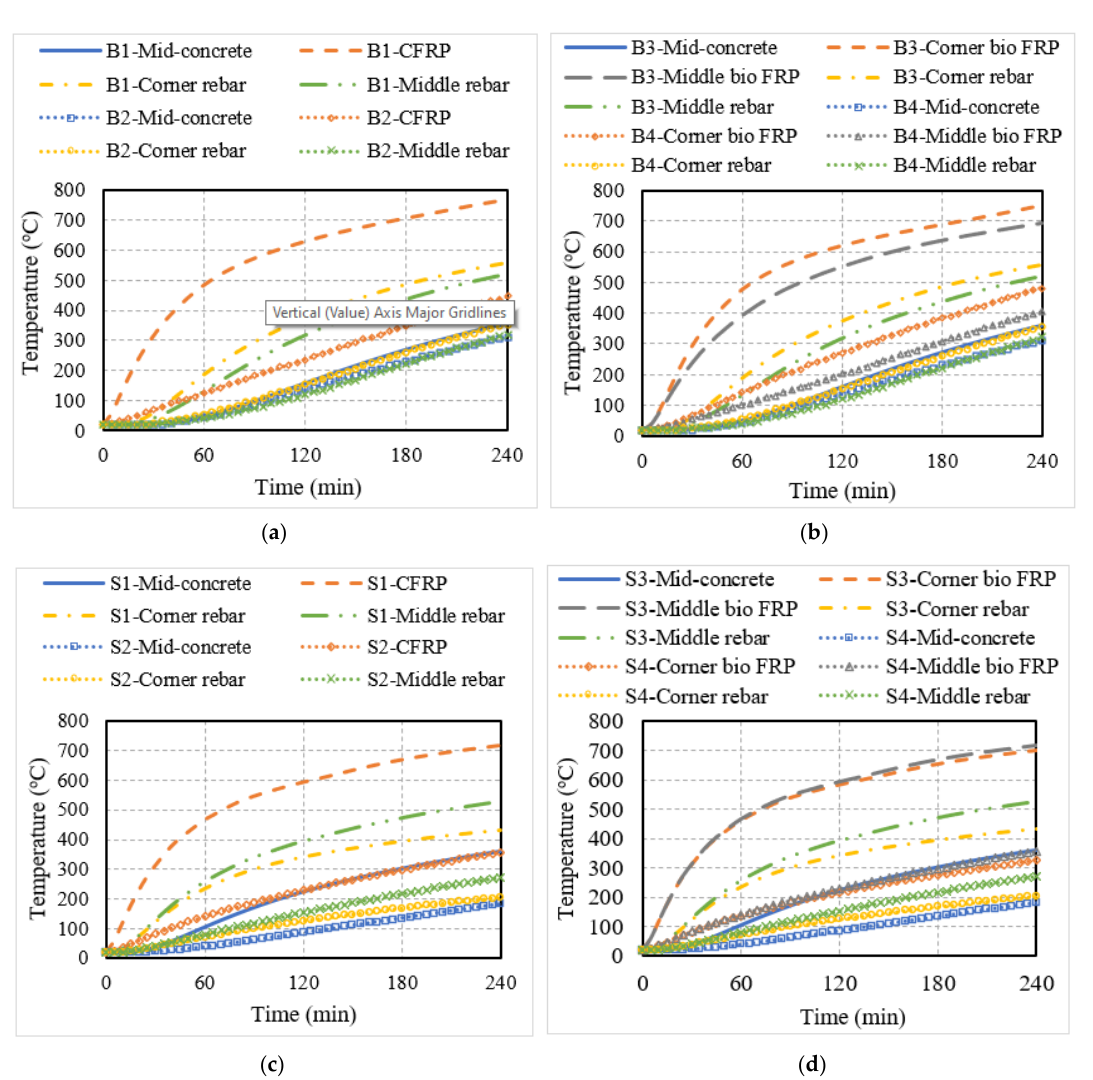
Figure 6. Thermal response of RC members strengthened with conventional or bio-based NSM FRP reinforcement. ( a ) NSM CFRP-strengthened T-beam; ( b ) NSM bio-based FRP-strengthened T-beam; ( c ) NSM CFRP-strengthened slab; ( d ) NSM bio-based FRP-strengthened slab.